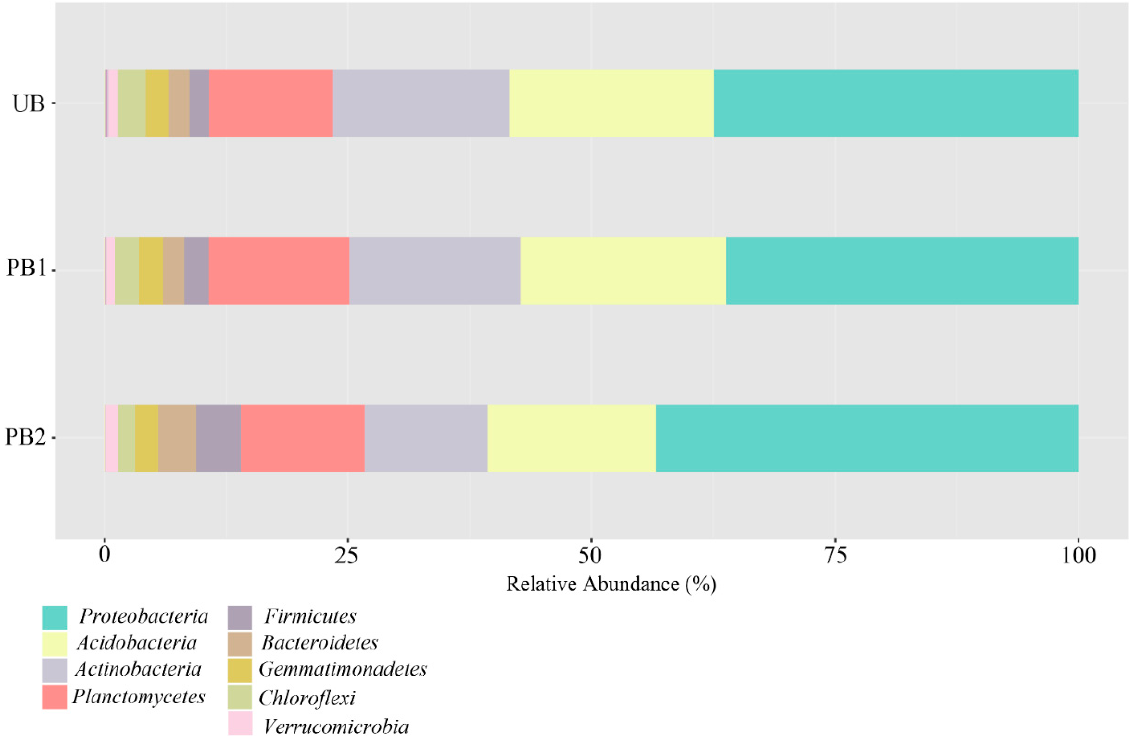
Figure 2. Distribution and relative abundances of bacterial phyla in burned (PB1 and PB2) and unburned control soils (UB). PB1: soils treated with prescribed burning seven months before sample collection; PB2: soils treated with prescribed burning immediately prior to sample collection.